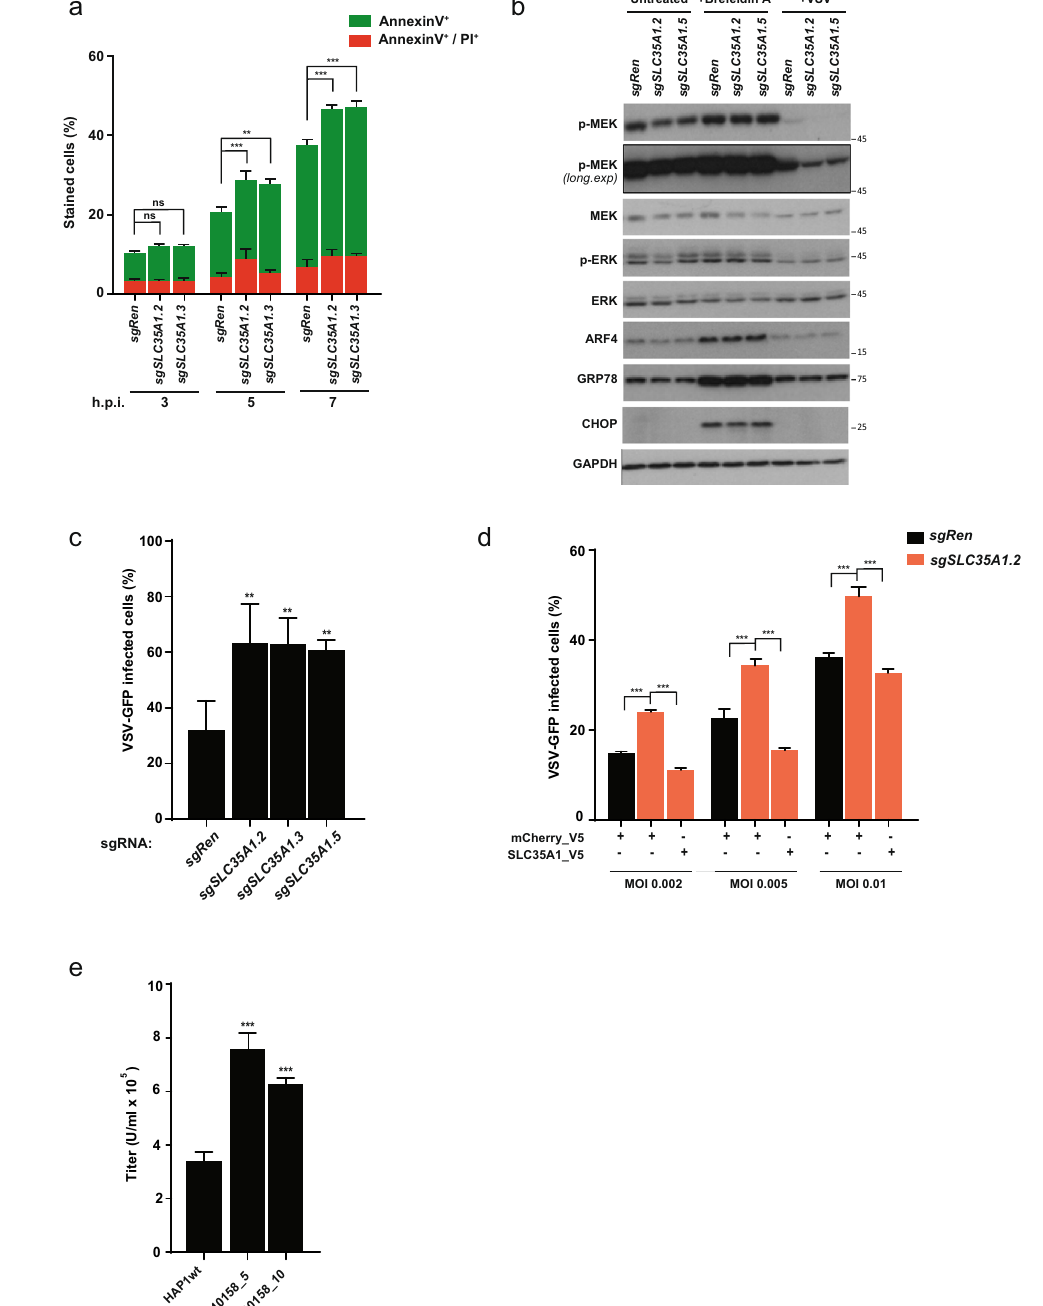
Figure 4. SLC35A1 loss promotes cell death and apoptosis upon VSV infection. ( a ) Percentage of early apoptotic cells (AnnexinV + ) and cells that lost membrane integrity due to a late apoptotic/necrotic state (AnnexinV + /PI + ) in HAP1 cell lines expressing sgRNAs against SLC35A1 and Renilla luciferase upon infection with VSV at MOI 2. ( b ) Immunoblot analysis of Golgi stress signalling pathway activation in the VSV-infected (MOI 2) and Brefeldin A-stimulated (3 μ g/ml) A549 cells carrying sgRNAs against SLC35A1 and Renilla luciferase . Cropped images are shown for conciseness. Full-length blots are presented in Supplementary Fig. 5. ( c , d ) VSV-GFP virus replication in SLC35A1 knockout HAP1 cells ( c ) and HAP1 cells overexpressing SLC35A1 cDNA ( d ) infected with MOI ranging from 0.001 to 0.01 for 14 hours. ( e ) Quantification (flow cytometry) of virus titers produced by HAP1wt and two SLC35A 1 single cell knockout clones infected with MOI of 2 of VSV- GFP for 8 hours. Statistical significance was assessed using one-way ANOVA with Tukey’s ( a , d ) and Dunnett’s ( c , e ) tests. Unless otherwise indicated, adjusted P-values in relation to sgRen control or HAP1wt are shown. Data are represented as mean ± SD of one representative experiment out of at least two independent